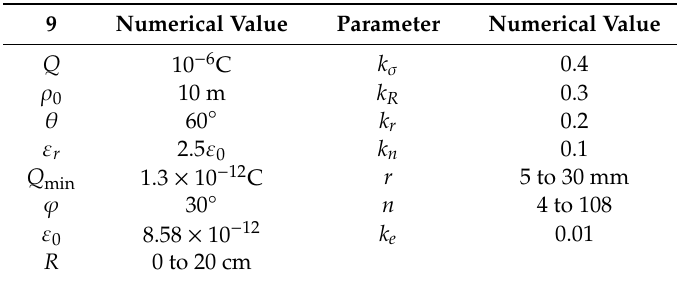
Table 2. Optimization model parameter